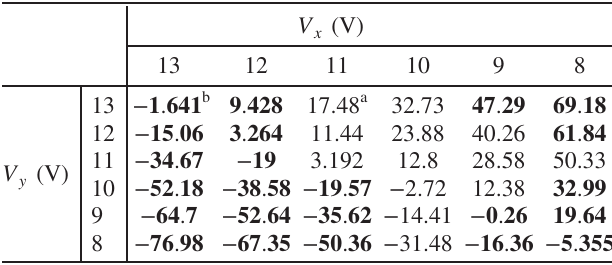
TABLE VI. Measured θ wave (at 10 GHz).